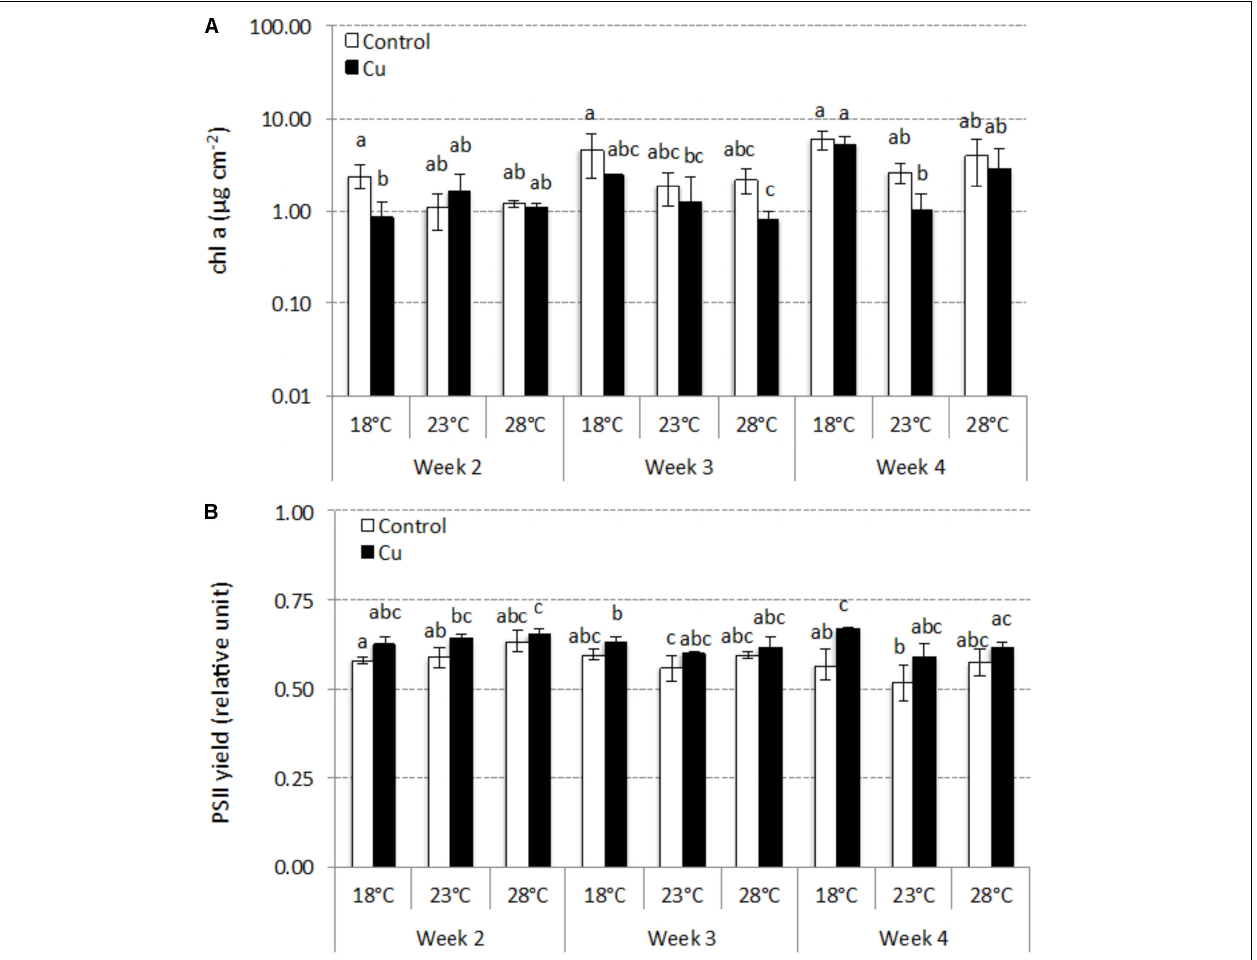
FIGURE 3 | Time-course of concentrations of chlorophyll a (mean ± SD, µ g cm − 2 ; n = 3) (A) and PSII yield (mean ± SD, relative units; n = 3) (B) between week 2 and week 4 in Control and Cu-exposed microcosms incubated at 18, 23, and 28 ◦ C. Different letters indicate significant differences between treatments (thermal and exposure context) at a given sampling time (ANOVA, p <